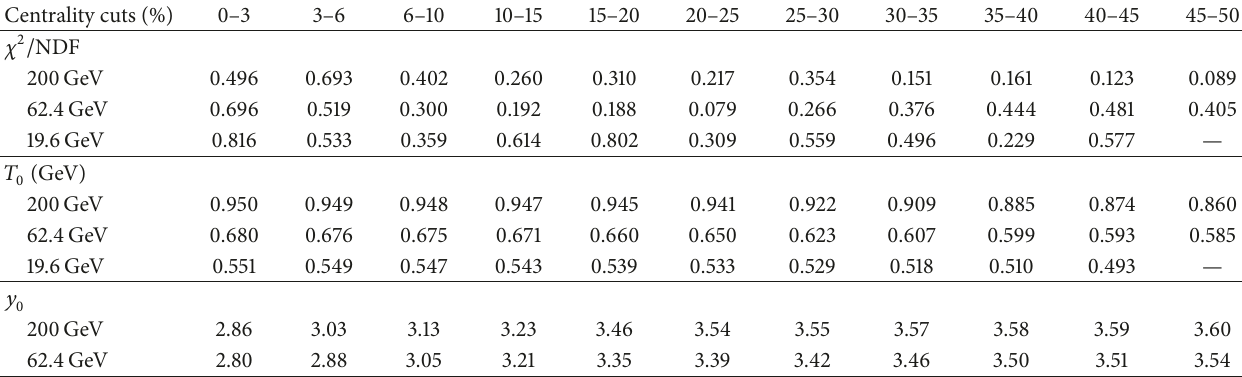
Table 1: 𝜒 2 / NDF, initial temperature 𝑇 0 , and central position 𝑦 0 in different centrality Au+Au collisions at √𝑠 NN = 200 , 62.4, and 19.6 GeV,